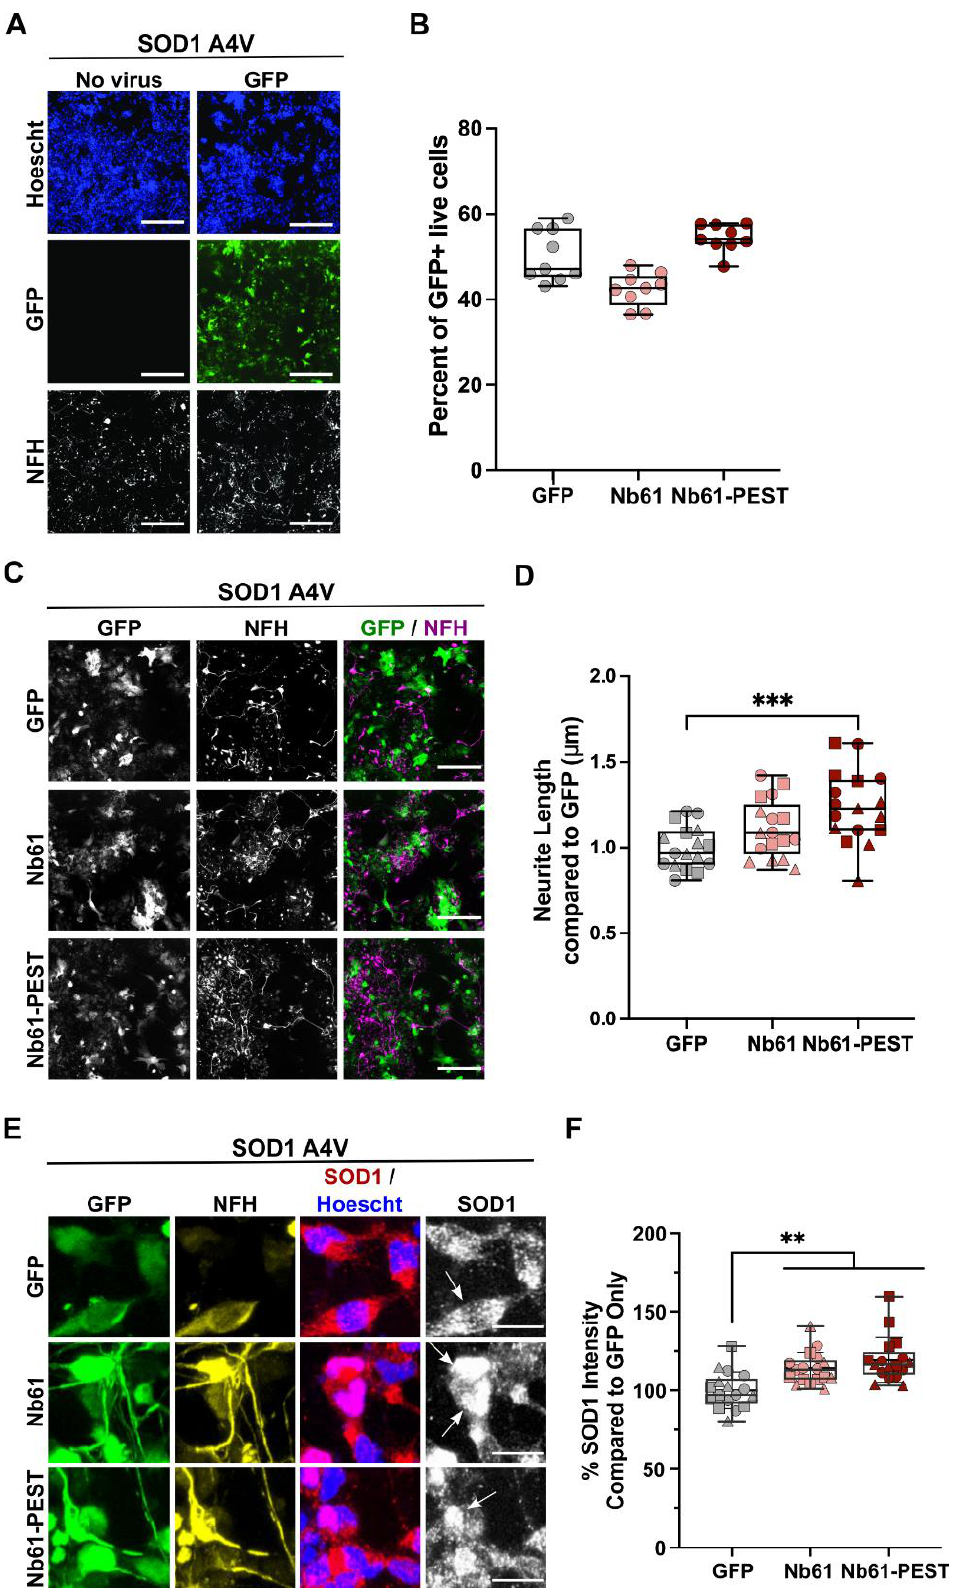
Figure 6. Nb61-PEST promotes neurite outgrowth in human SOD1 A4V motor neurons. SOD1 A4V iPSC-derived human motor neurons were thawed, plated into 384-well dishes, and assessed under various conditions after 7 days in culture. ( A ) Immunofluorescence images of human SOD1 A4V neurons that were untreated (left) or treated (right) with a control lentivirus expressing GFP. Neu- rofilament heavy (NFH, SMI32) staining identified motor neurons. Scale bar = 200 µm. ( B ) Quanti- fication of the transduction efficiency for a control lentivirus expressing GFP or lentiviral constructs expressing either Nb61 or Nb61-PEST with a GFP reporter. Data are compiled from multiple wells (each point represents one well) from a representative biological replicate. ( C ) Immunofluorescence images of SOD1 A4V neurons that were transduced with the indicated lentivirus and stained as in